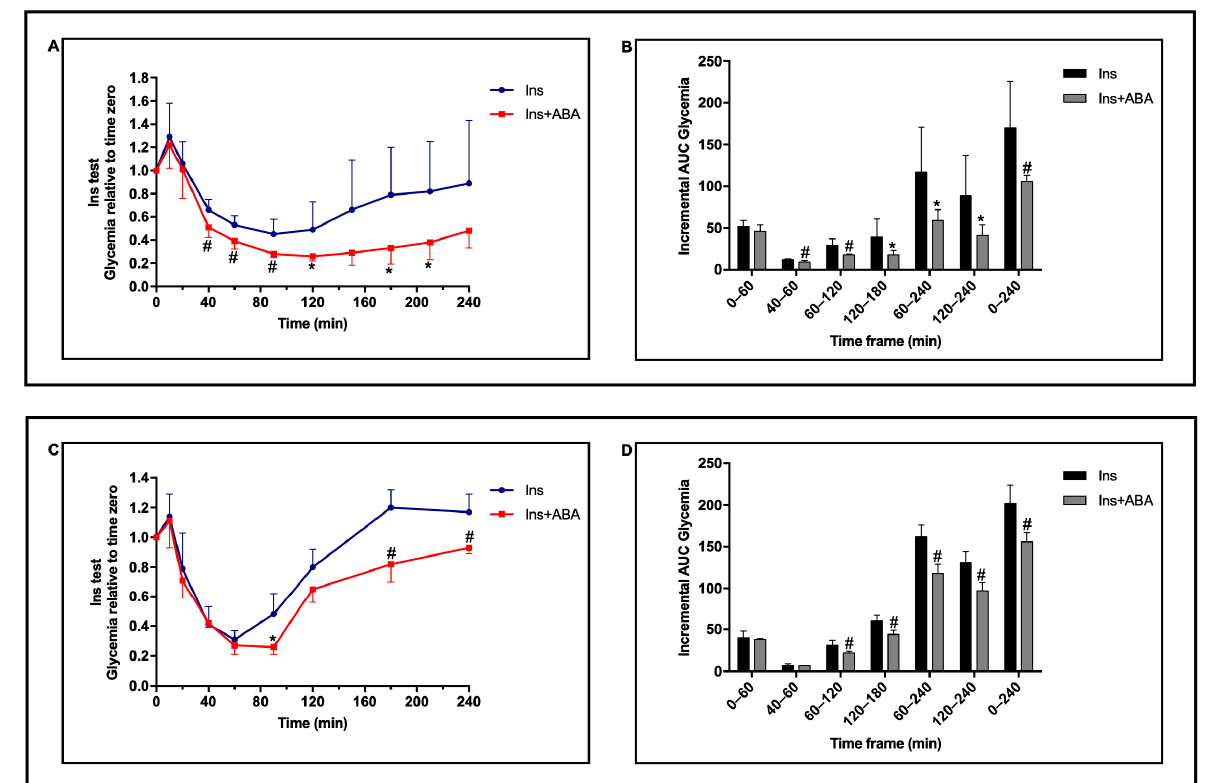
Figure 2. A single dose of oral ABA in addition to insulin improves glycemia control in hyperglycemic mice. LANCL2+/+ (wild-type) mice (8/group) received a single high-dose STZ injection (200 mg/Kg BW). When glycemia was >300 mg/dL in all animals, a first insulin test was performed (upper panel) with 0.1 U of insulin injected s.c. without (Ins) or with (Ins + ABA) the concomitant administration of 5 µg/Kg BW of ABA by gavage ( A , B ). A similar insulin test was repeated when glycemia was >500 mg/dL in all animals (lower panel, C , D ). ( A , C ): glycemia profile during the insulin test. ( B , D ): incremental AUC of glycemia in the respective insulin test shown in the opposite panel (panel A or C ), as calculated in the indicated timeframes. * p < 0.05 and # p < 0.02 relative to Ins. p values are calculated by unpaired two-tailed t -test.